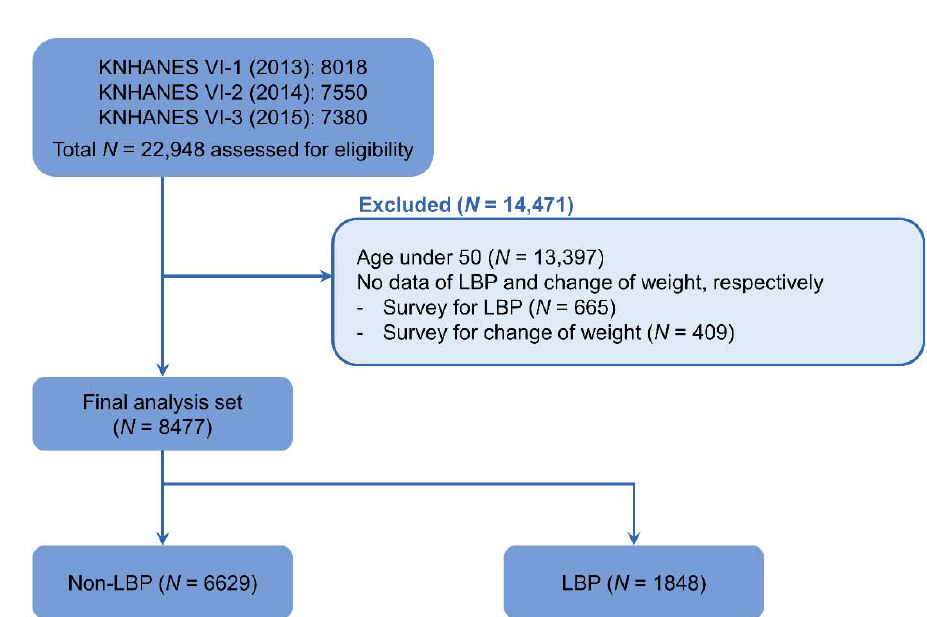
Figure 1. Flow chart of study subjects from the 2013 to 2015 Korea National Health and Nutrition Examination Surveys (KNHANES VI-1, VI-2, and VI-3). LBP, low back pain.